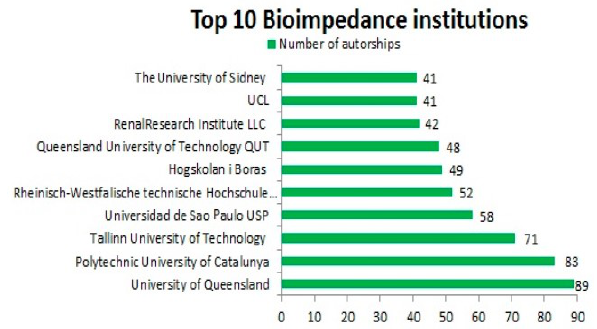
Fig. 2: A graph showing the most active institutions in publishing in the bioimpedance field (extracted from the Scopus based analysis [1], published under CC BY